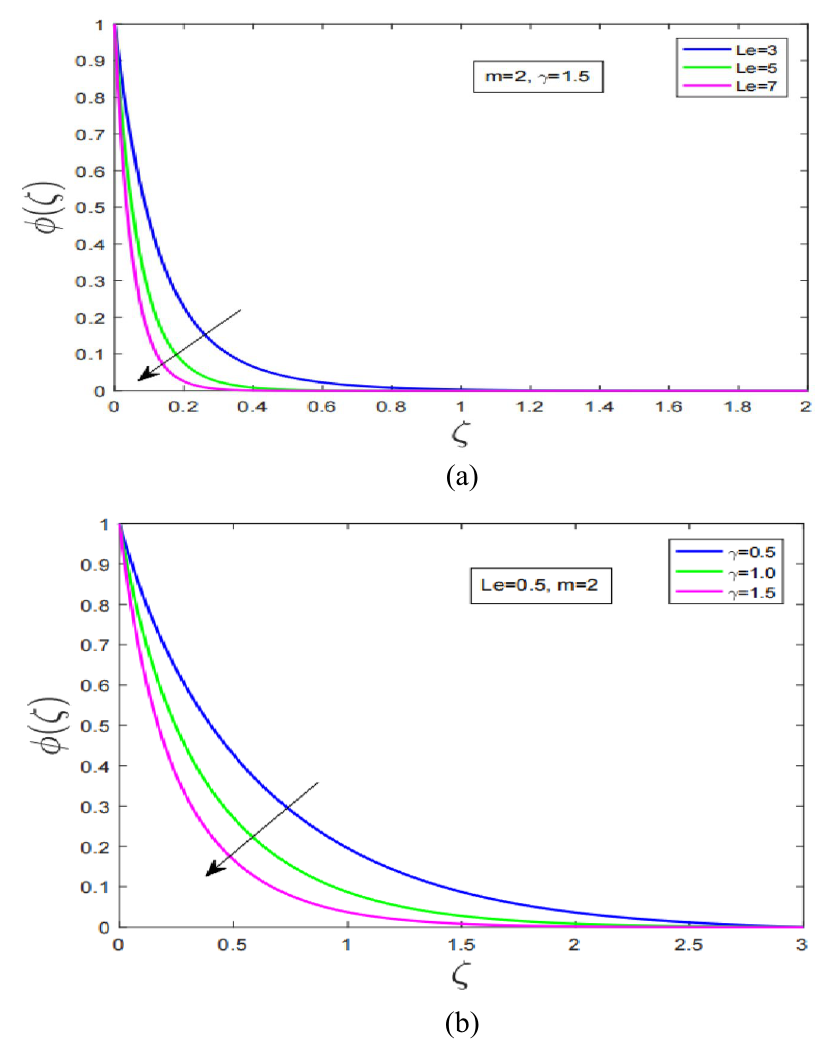
Figure 4. ( a ) Lewis number impact on φ . ( b ) Chemical reaction Influence on φ .